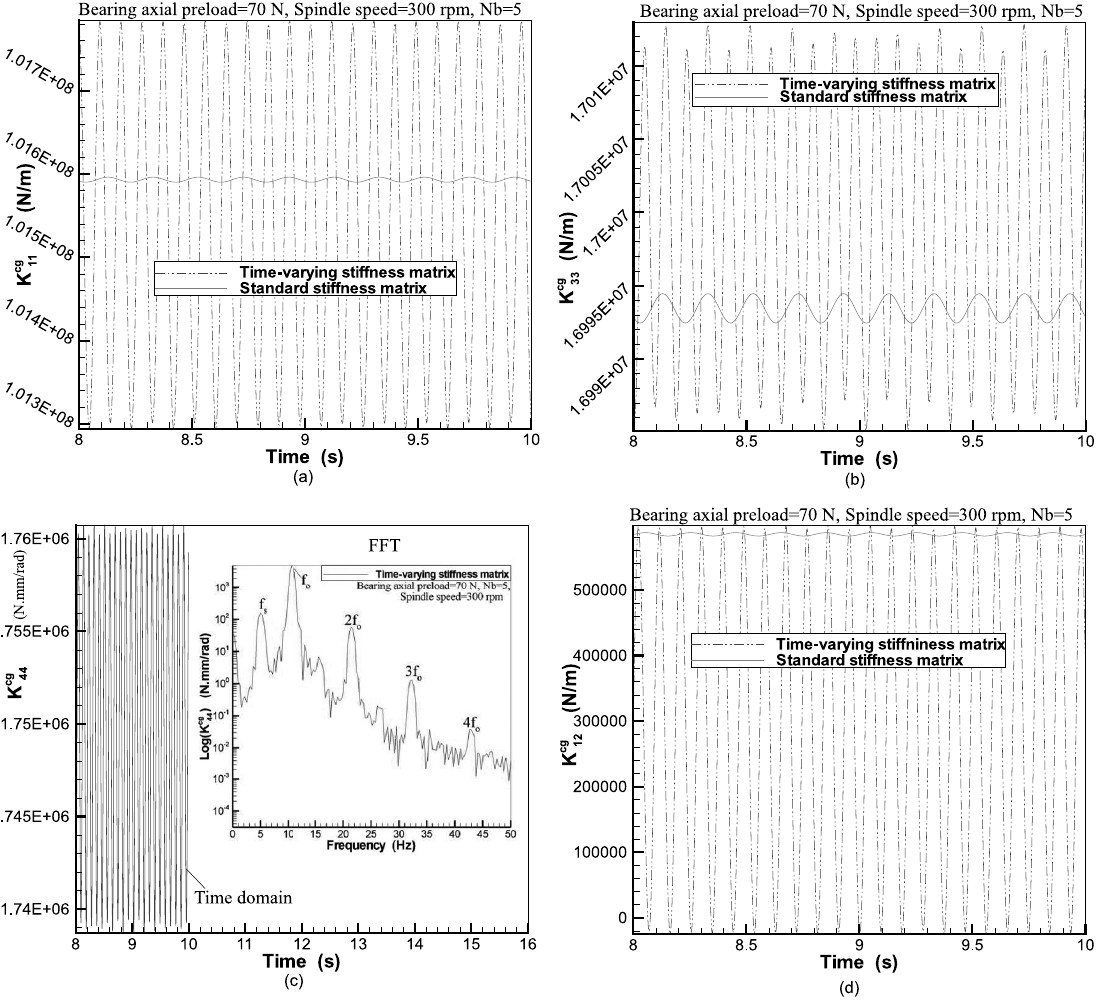
Fig. 10. (a): Time domain of K cg 11 for time-varying stiffness matrix (dash-dot-dot line) and standard stiffness matrix (solid line). External load is 203 N force acting in the vertical plane at gravity center and is inclined at 9.87 deg to the positive X s . Ω s = 300 rpm. mass unbalance eccentricity = 18 μm . Nb = 5, bearing axial preload = 70 N. (b): As in (a) but for K cg 33 for time-varying stiffness matrix (dash-dot-dot line) and standard stiffness matrix (solid line). (c): Time domain and FFT of K cg 44 for time-varying stiffness matrix. Same input data as in (a) (d): As in (a) but for K cg 12 for time-varying stiffness matrix (dash-dot-dot line) and standard stiffness matrix (solid line). (e): As in (a) but for K cg 35 for time-varying stiffness matrix (dash-dot-dot line) and standard stiffness matrix (solid line). (f): FFT of K cg 35 in (e) for time-varying stiffness matrix (dash-dot-dot line) and standard stiffness matrix (solid line). (g): Time domain of K cg 35 for time-varying stiffness matrix. Same input data as in (a) except that Nb = 16. (h): FFT of K cg 35 in (g) (dashed line) and FFT of its counter part ( K cg 35 ) of standard stiffness matrix (solid line). (i): Time domain and FFT of K cg 45 for time-varying stiffness matrix. Same input data as in (a) except that Nb =